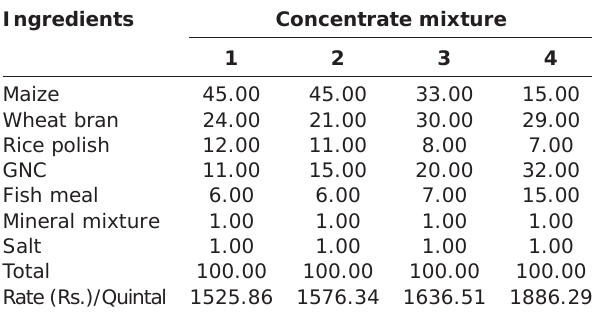
Table-1: Gross composition (%) and rate of concentrate mixture used in the experiment. Ingredients